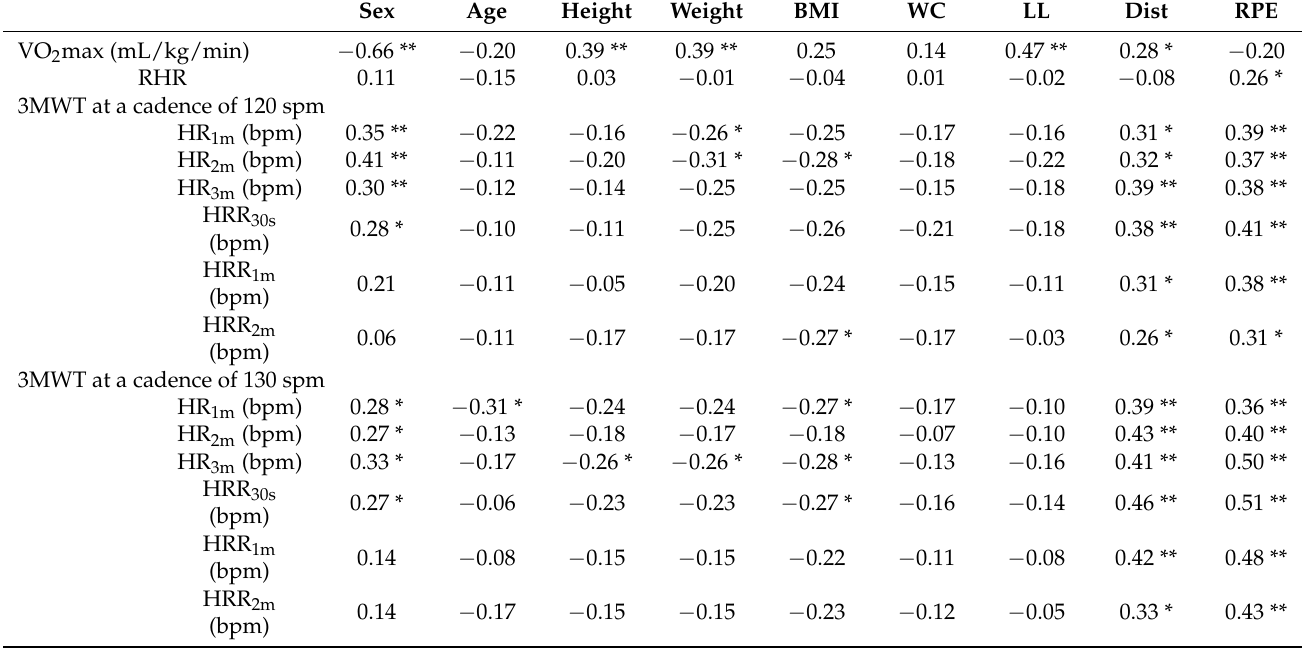
Table 3. Correlation of anthropometric measurements and exercise related variables.